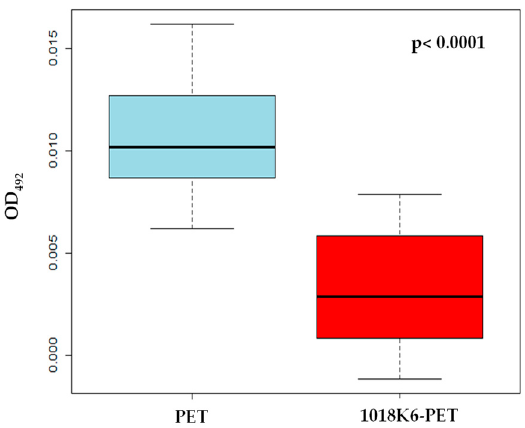
Figure 7. Boxplot of the inhibition activity of the biofilm production of Listeria monocytogenes by PET and 1018K6-PET. Average OD measurements of crystal violet-stained biofilms are shown with error bars representing the standard deviation.